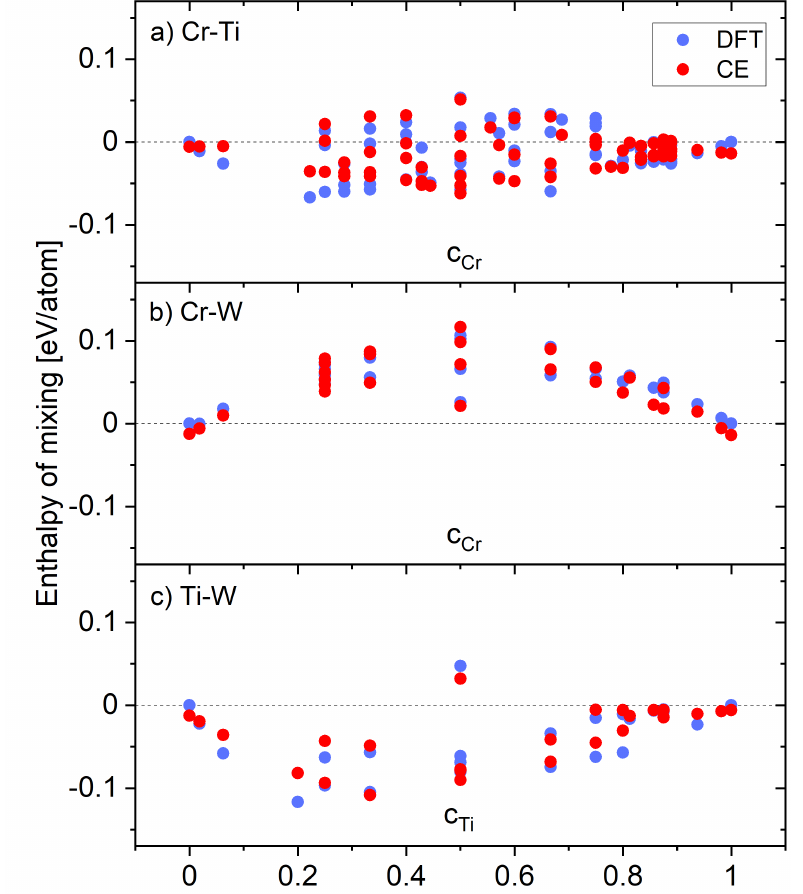
Figure 10. Enthalpies of mixing of bcc binary structures for ( a ) Cr-Ti, ( b ) Cr-W, and ( c ) Ti-W systems from DFT (blue) and CE (red)